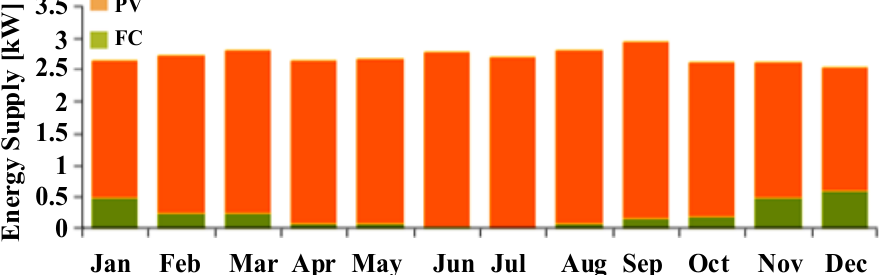
Figure 9. Monthly electric loads power supply by the PV and FC. The thermal demand of the system is largely provided by the gas boiler 68.6% (5861‘kWh/yr), TLC 16.8% (1431 kWh/yr), and FC 14.6% (1247 kWh/yr). This shows